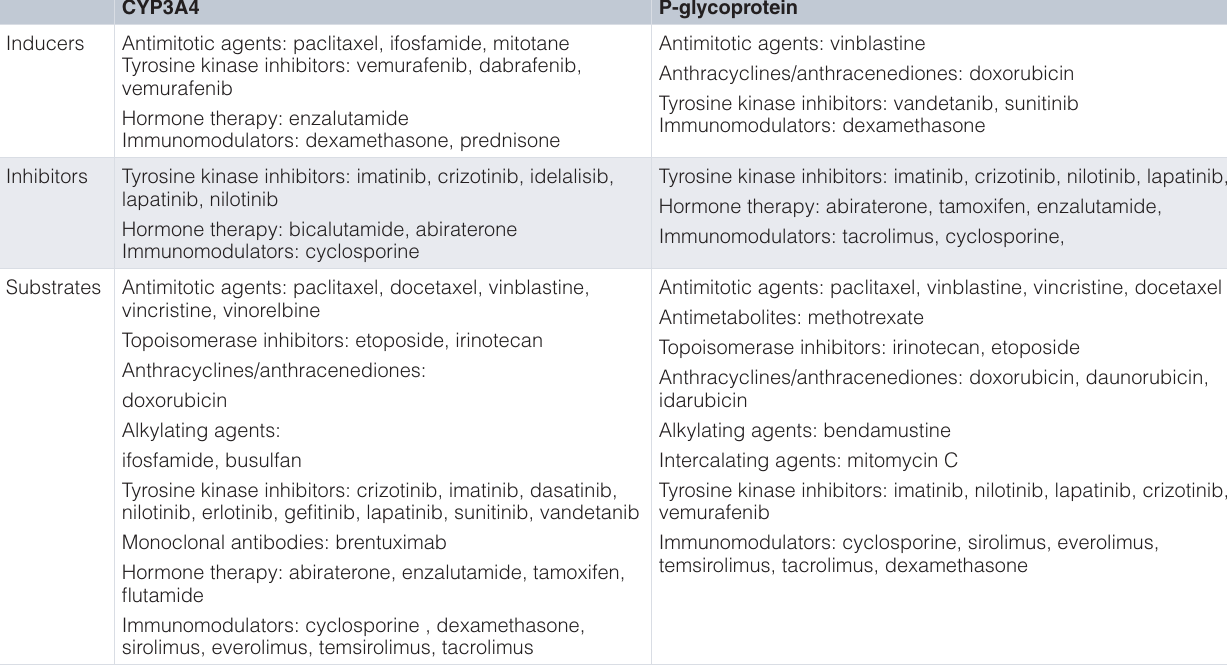
Table 4. Anti-cancer treatments predicted to affect direct oral anticoagulant plasma levels through moderate to strong interaction with CYP3A4 or P-glycoprotein or both. CYP3A4 P-glycoprotein